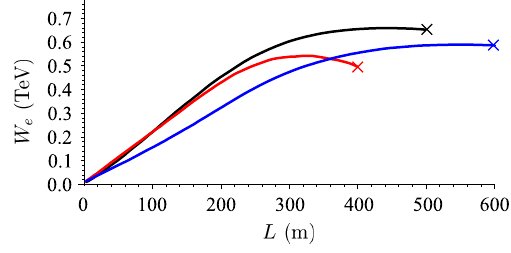
FIG. 14. (Color) Effect of the plasma density: witness energy growths for various average plasma densities: 10 15 cm (cid:1) 3 (black), 4 (cid:2) 10 14 cm (cid:1) 3 (blue), and 2 (cid:2) 10 15 cm (cid:1) 3 (red).